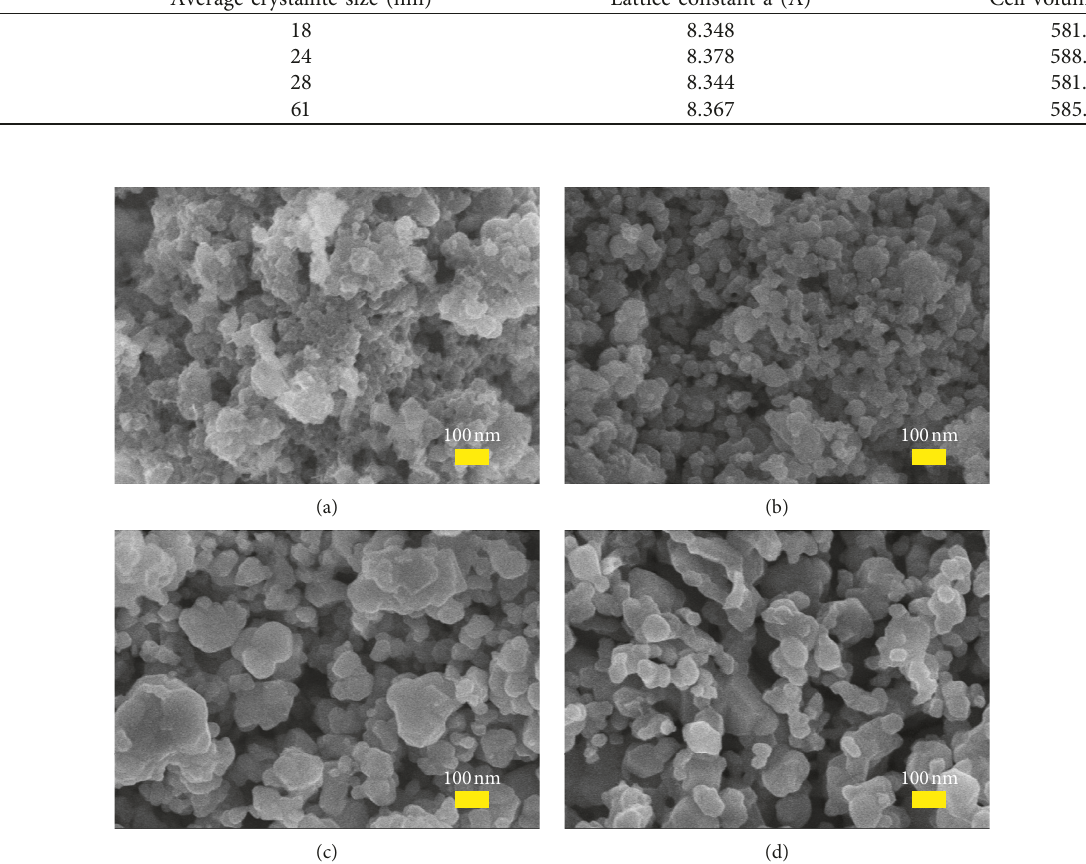
Figure 3: SEM of MgFe ° C (a), 600 ° C (b), 700 ° C (c), and 800 ° C 2 O 4 calcined samples at 500